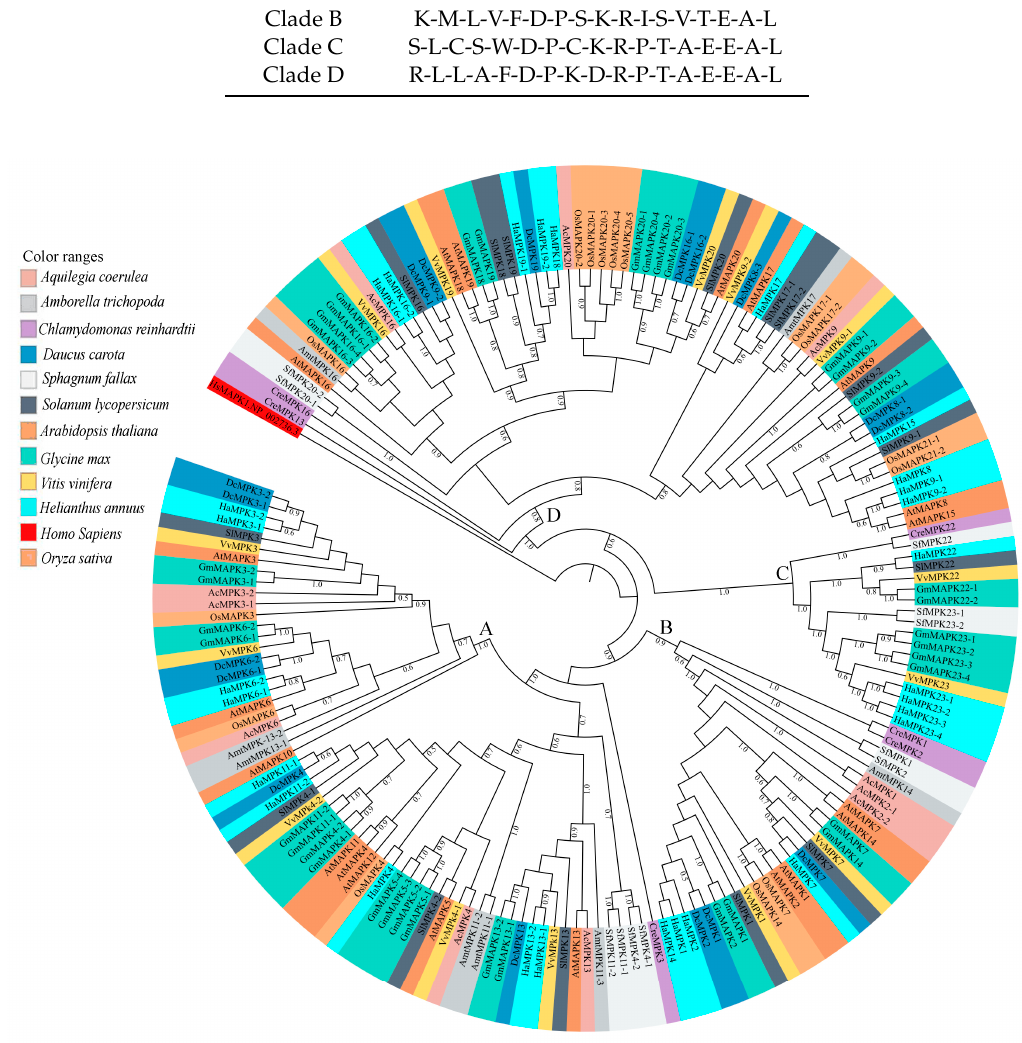
Figure 3. Maximum Likelihood (ML) tree constructed using full length amino acid sequences from Amborella trichopoda (Amt), Arabidopsis thaliana (At), Aquilegia coerulea (Ac), Chlamydomonas reinhardtii (Cre), Daucus carota (Dc), Glycine max (Gm), Helianthus annuus (Ha), Oryza sativa (Os), Solanum lycopersicum (Sl), and Sphagnum fallax (Sf), and Vitis vinifera (Vv) MPK proteins. Phylogenetic analysis with 100 bootstrap replicates was performed in the program MEGA7. Homo sapiens , HsMAPK1 (GenBank: NP_002736.3) was used as an outgroup. Different species are color-coded, and the MPK clades are labeled A–D. The Clade A members include the previously identified group A (MPK3, MPK6, MPK10) and B (MPK4, MPK5, MPK11, MPK12, MPK13) members of A. thaliana MPKs [3,4]. The Clade B members include the previously identified group C (MPK1, MPK2, MPK7, and MPK14) members of A. thaliana MPKs [3,4]. The Clade C members include the previously identified group E (MPK22 and MPK23) members of soybean MPKs [26]. The Clade D members include the previously identified group D (MPK8, MPK9, MPK16, MPK17, MPK18, MPK19, MPK20, and MPK21) members of A. thaliana MPKs [3,4].